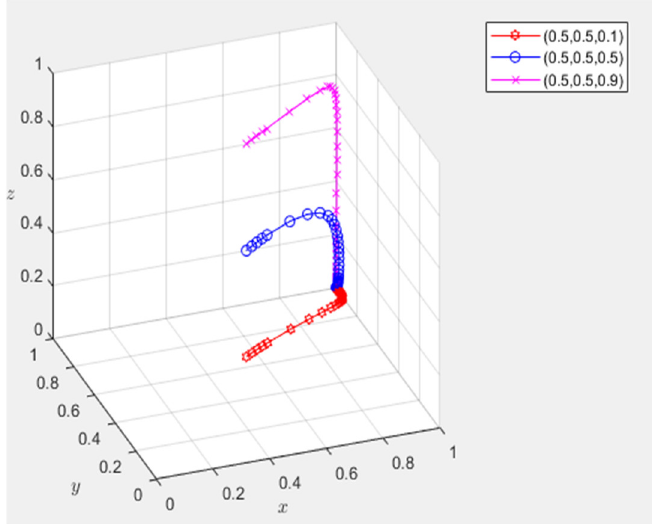
Figure 2. Influence of quality inspection department.